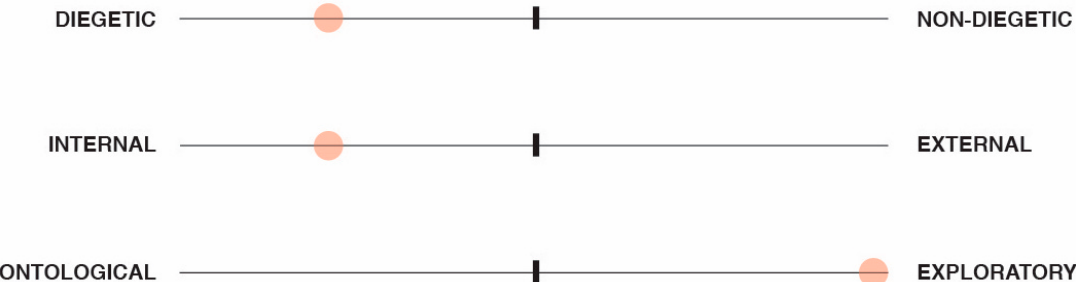
Figure 12. Mapping the case study project Multi-Sensory Prayer Nuts using the TENF.